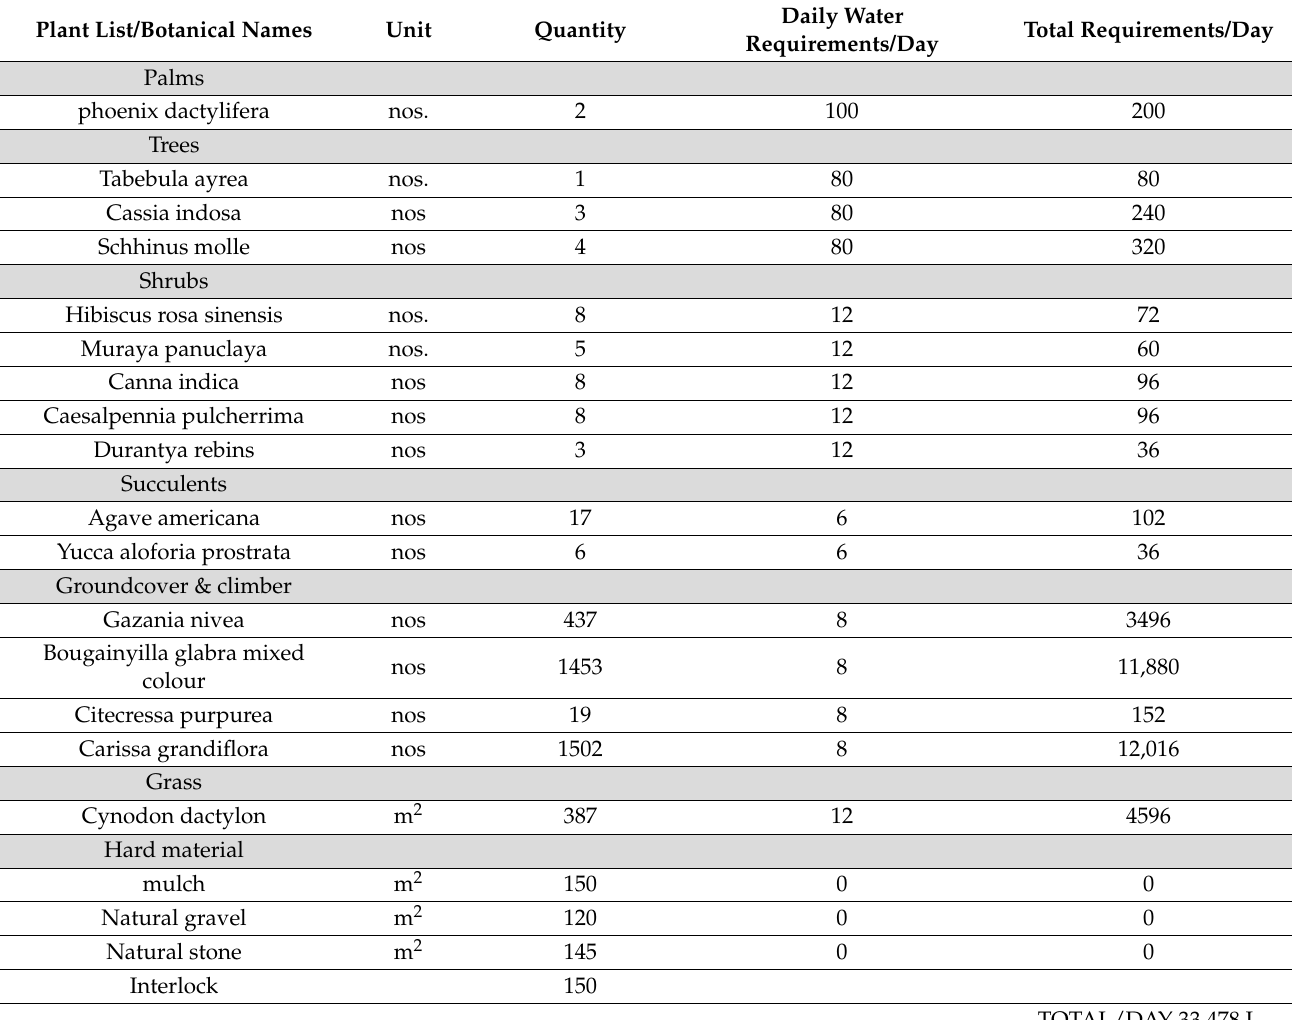
Table A5. Water consumption for each softscape item: Applying xeriscaping for PARKING 14 landscape.